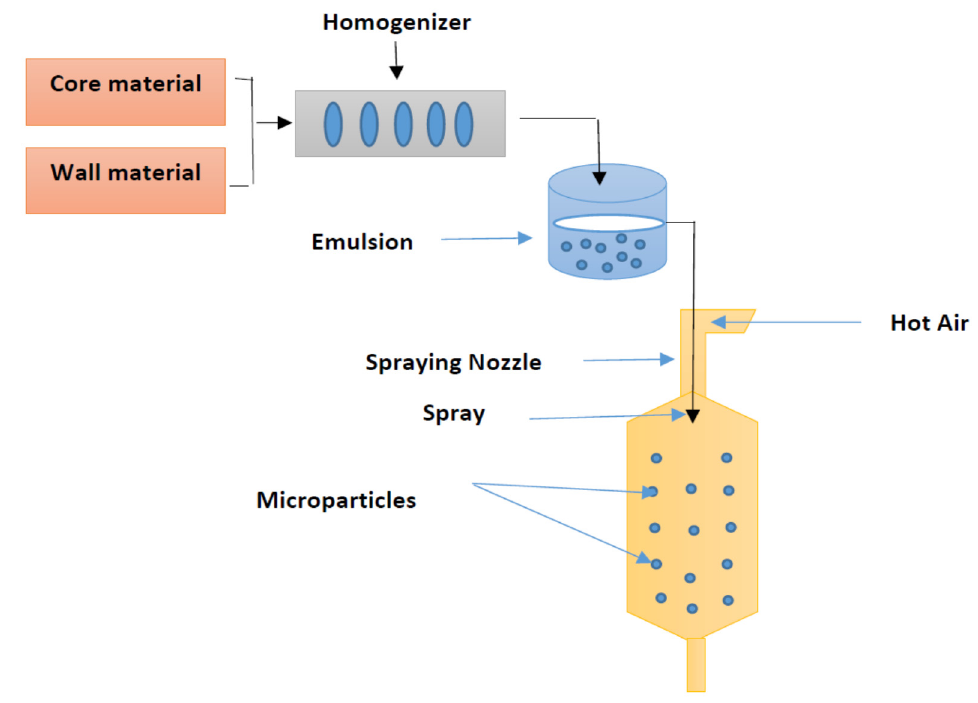
Figure 1. Schematic representation of the encapsulation process by spray-drying